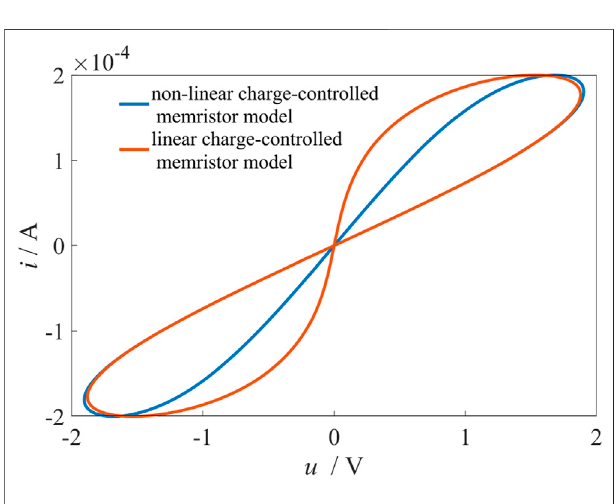
FIGURE 3 | The hysteresis loop of the HP memristor under i (cid:2) 2 × 10 − 4 sin(2 π t ) for linear and non-linear charge-controlled memristor